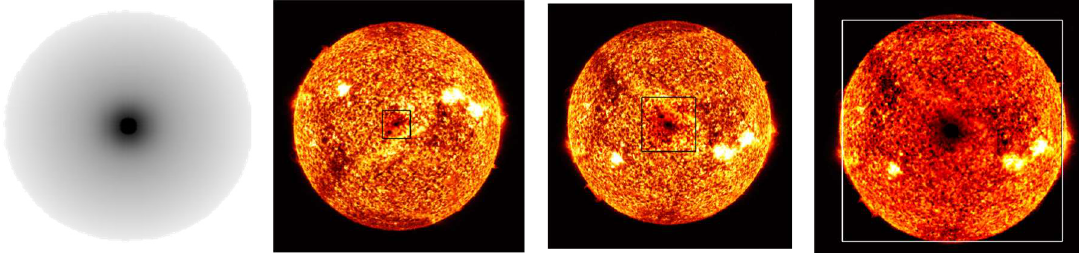
Figure 11. The Earth’s exosphere is a hydrogen envelope that extends further than 30 R ⊕ . This envelope absorbs efficiently the stellar Ly α photons producing a measurable effect [34]. The transmittance of the Earth’s exosphere to Ly α photons is outlined in left panel (black corresponds to transmittance 0 and white to transmittance 1). On the left panel, several images of the Sun’s chromospheric emission have been scaled to the size of the Sun, AU Mic and Proxima Centauri and multiplied by this mask. The size of the Earth’s exosphere is comparable to the radius of an M5 V star (right panel), covers a large fraction of the disk of an M0 V star (central right panel), and is small compared with the Sun (central left panel). The squares in the color panels have a size of 30R ⊕ × 30R ⊕ .